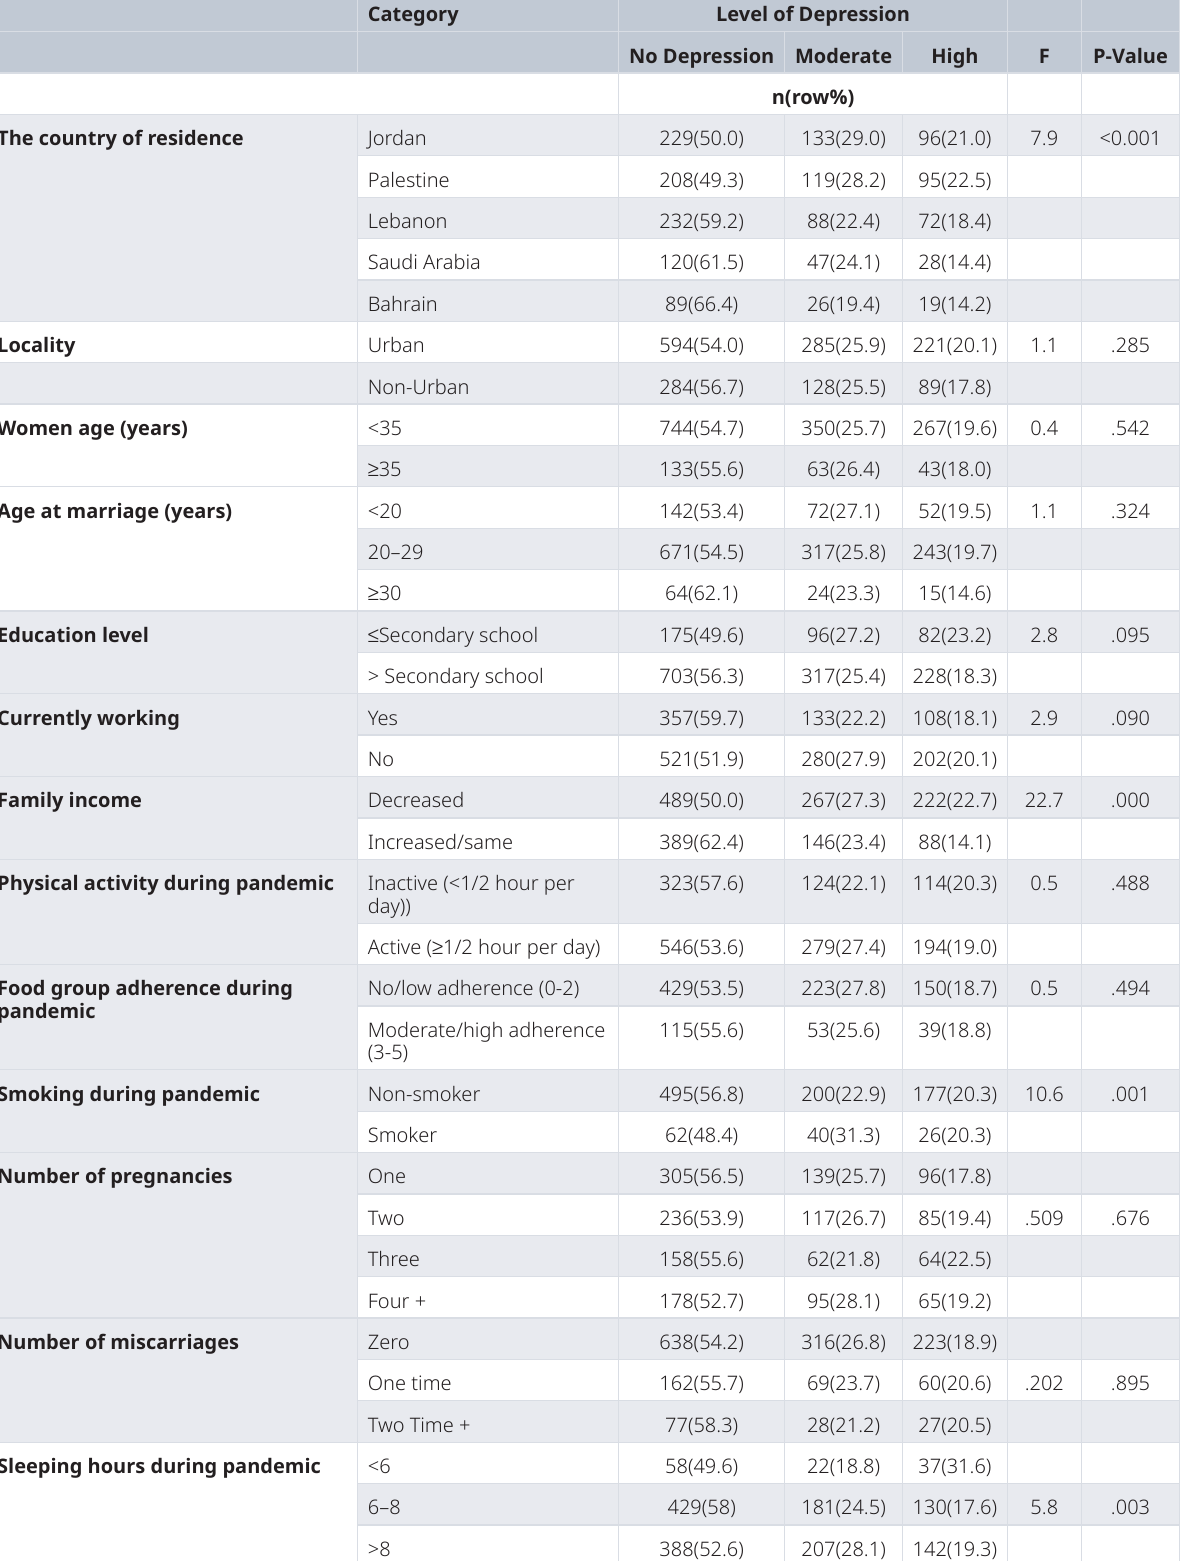
Table 2. Descriptive analysis of study variables and maternal